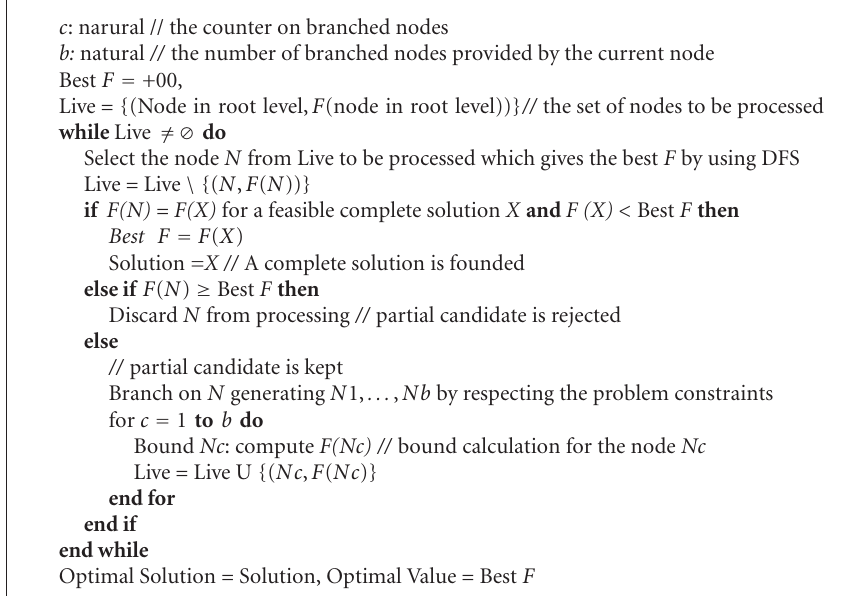
Algorithm 3: Branch and Bound for hardware task placement